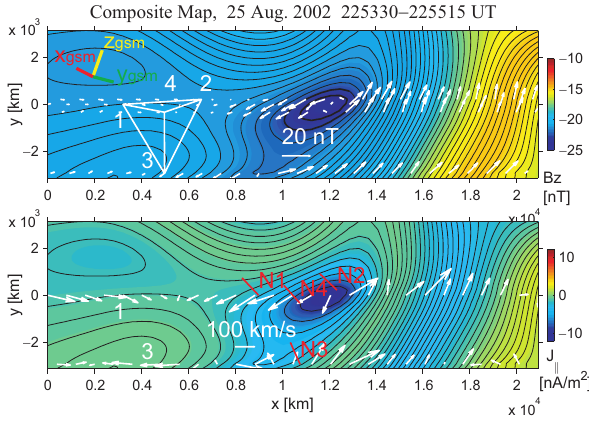
Fig. 35. Field maps for an FAC filament at the dawn flank of a BBF encountered by Cluster. Colors in the top and bottom panels show the out-of-plane field component B z and field-aligned cur- rent estimated from the recovered fields, respectively (see Snekvik et al., 2007, for details). White arrows represent measured fields and velocities in the top and bottom, respectively. Note that the axes x , y and z here are not in GSM, but in the GS reconstruction coordinates. The GS axes are in GSM: x =( − 0.585, 0.737, 0.338), y =(0.295, − 0.195, 0.936), and z =(0.755, 0.647, − 0.103).